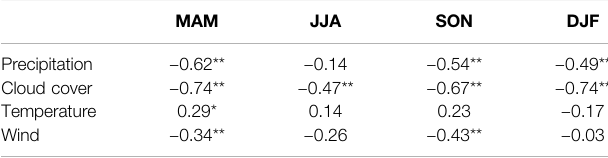
TABLE 3 | Correlation coef fi cients of the PRR in different seasons with the local averageprecipitation,totalcloudcover,surfacetemperatureandsurfacewind speed in the